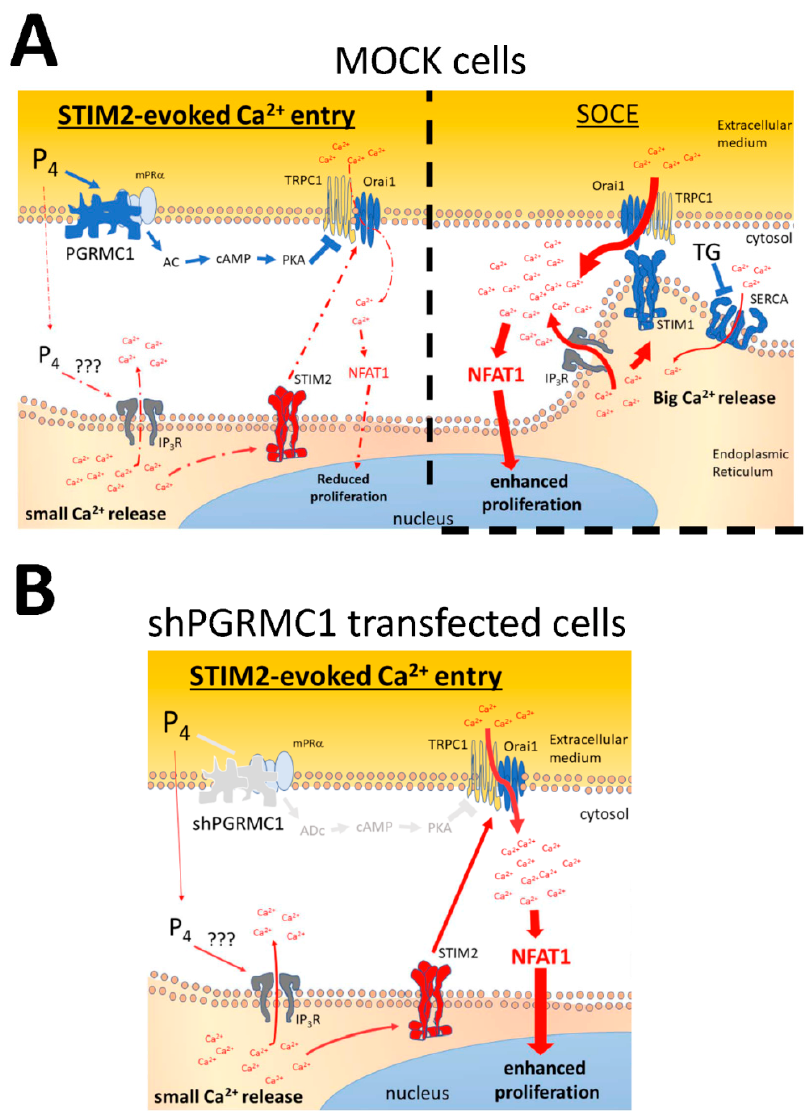
Figure 10. Schematic representation of the proposed mechanism of the P 4 effects on Ca 2+ homeostasis. ( A ) In MDA-MB-231 cells, STIM2 detects the small intraluminal Ca 2+ changes evoked by P 4 and activates a Ca 2+ entry through Orai1 and TRPC1, which is limited due to P 4 -dependent PGRMC1 activation. PGRMC1 downstream mechanisms involve the activation of PKA that phosphorylates Orai1 and, thus, downregulates Ca 2+ entry and cell proliferation. ( B ) Silencing of PGRMC1 results in an increase in the P 4 -evoked STIM2-dependent Ca 2+ entry that leads to NFAT1 translocation to the cell nucleus and, therefore, reverses the negative effect of P 4 in the proliferation of MDA-MB-231 cells.